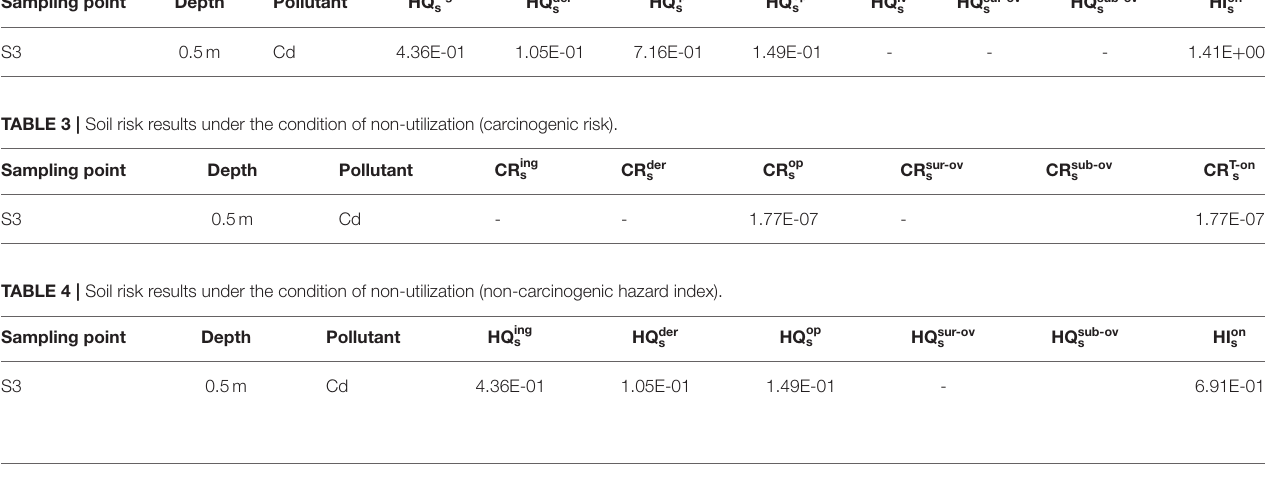
TABLE 2 | Soil risk results under the condition of reutilization (non-carcinogenic hazard index). Sampling point